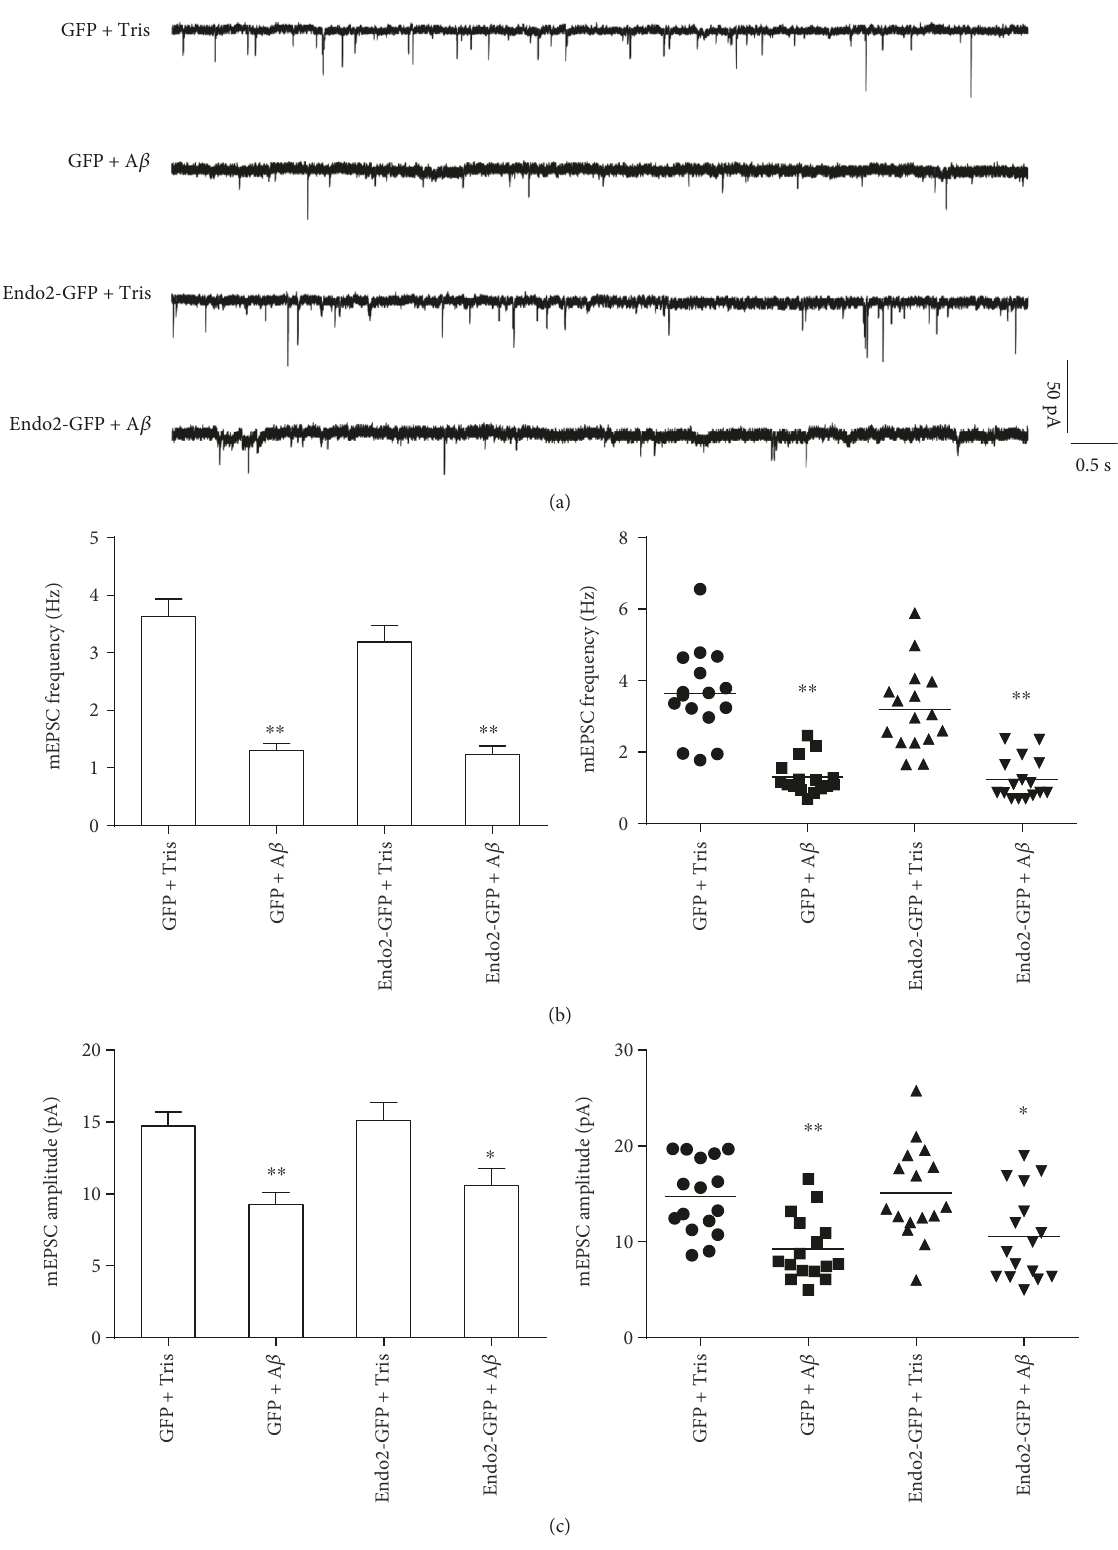
Figure 3: The electrophysiology of endophilin2 overexpression in neurons processed by oligomeric A β . (a) mEPSC tracings are shown in control and oligomeric A β -processed neurons transfected with GFP and Endo2-GFP. (b) Histogram plots and scatterplots of mEPSC frequency in control and oligomeric A β -processed neurons transfected with GFP and Endo2-GFP, n = 16 cells, 4 cultures from 8 SD rats, ∗∗ P < 0 005 . (c) Histogram plots and scatterplots of mEPSC amplitude in control and oligomeric A β -processed neurons transfected with GFP and Endo2-GFP, n = 16 cells, 4 cultures from 8 SD rats, ∗ P < 0 05 , ∗∗ P < 0 005